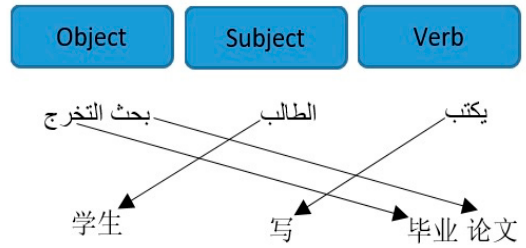
Figure 1. Example of the sentence order in Arabic and Chinese.